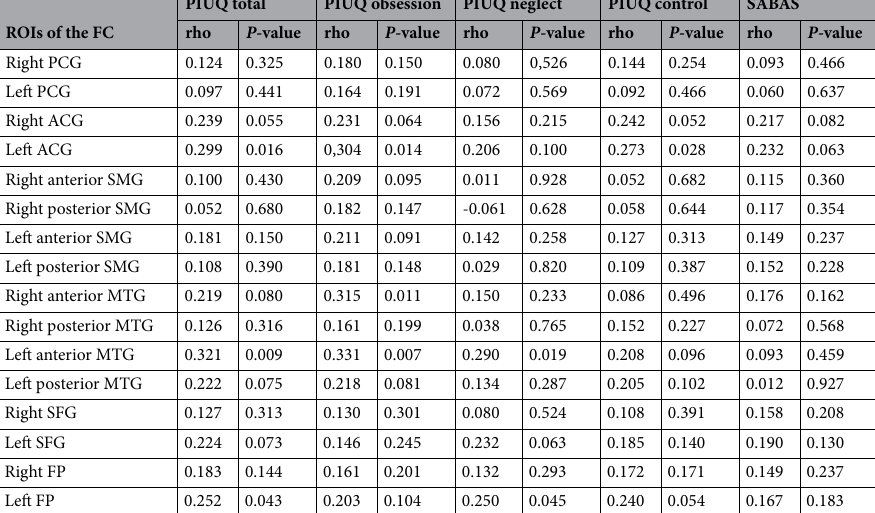
Table 4. ROI analysis results with left amygdala seed region. Positive correlations between questionnaire scores and FCs. Rho- Spearman’s correlation coefficients and uncorrected P -values are presented; PIUQ– Problematic Internet Use Questionnaire; SABAS–Smartphone Application-Based Addiction Scale; PCG- posterior cingulate gyrus. ACG-anterior cingulate gyrus; SMG-supramarginal gyrus, MTG-middle temporal gyrus; SFG-superior frontal gyrus; FP-frontal